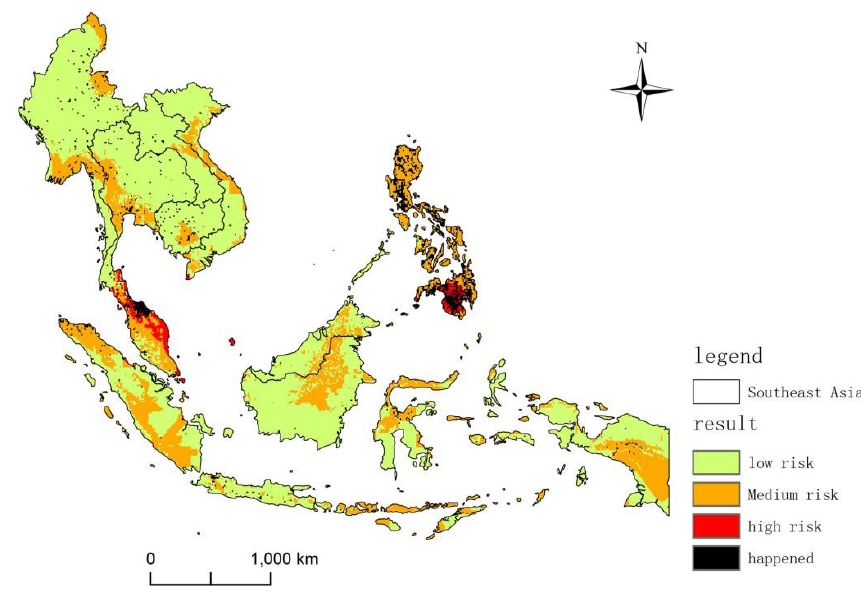
Figure 10. Terrorist attack risk map.